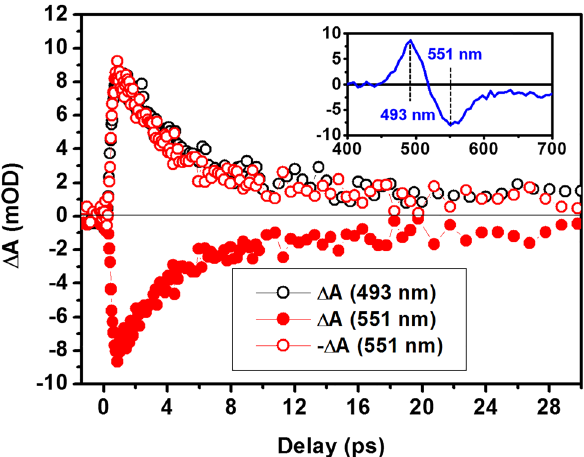
Figure4: TAdynamicsat493(emptyblackcircles)and551nm( fi lled red circles), as well as the inversed TA dynamics at 551 nm (empty red circles) that is rescaled a bit to be normalized to that at 493 nm. Inset: TA spectrum at a delay of 1 ps.